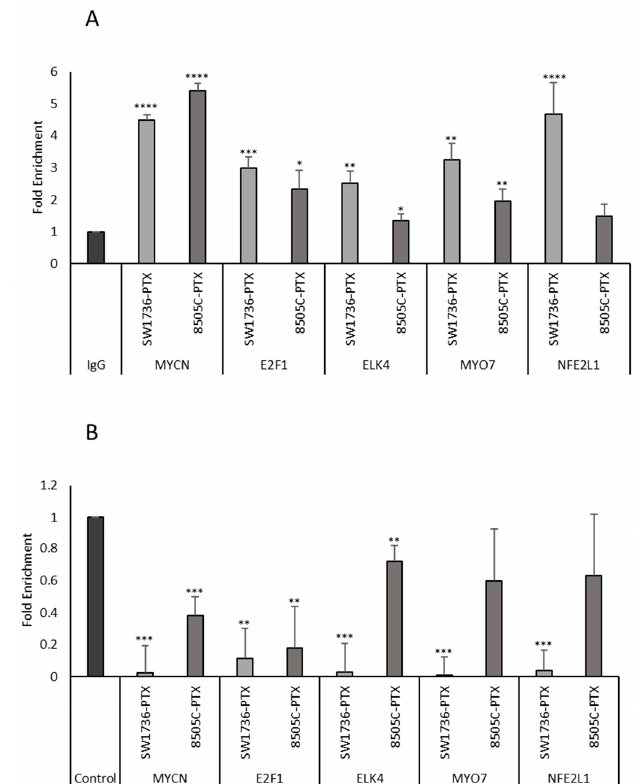
Figure 6. Chromatin was isolated from SW1736-PTX and 8505C-PTX cell lines and immunoprecipitated with BRD9 or IgG antibodies. MYCN , E2F1, ELK4, MYO7, NFE2L1 DNAs were amplified using promoter-specific primers and analyzed by qPCR. All samples were run in triplicate. IgG-immunoprecipitate was arbitrarily set at 1.0 and the enrichment was expressed as relative expression value panel ( A ). SW1736-PTX and 8505C-PTX cells were treated with GSK2801 20 µ M or with DMSO only (control). After chromatin was immunoprecipitated with BRD9 or IgG antibodies, MYCN , E2F1, ELK4, MYO7, NFE2L1 DNAs were amplified using promoter-specific primers and analyzed by qPCR panel ( B ). All samples were run in triplicate. Enrichment versus IgG of control (cells not treated with GSK2801) was arbitrarily set at 1 (control). n = 3. * p < 0.05, ** p < 0.01, *** p < 0.001, **** p <